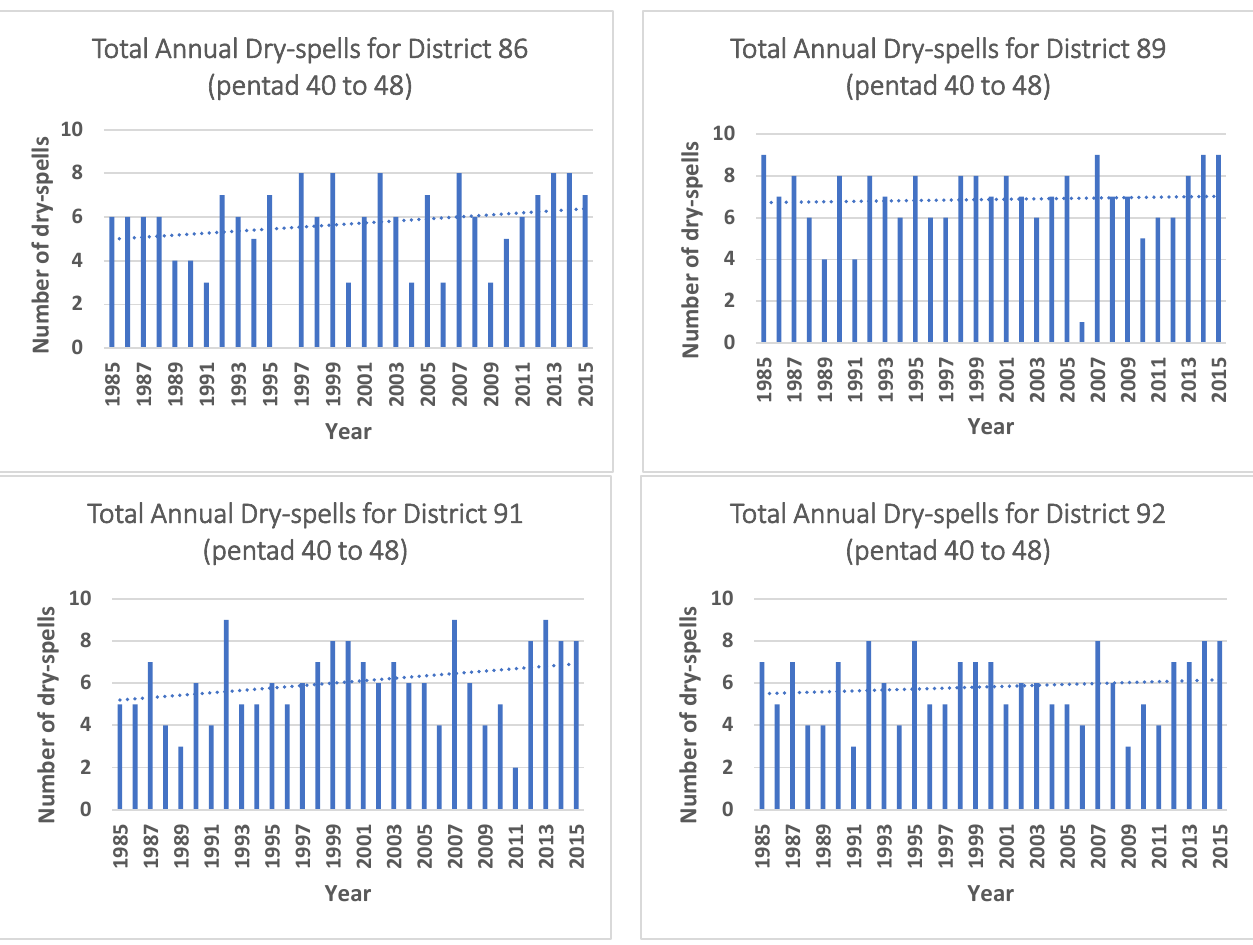
Figure 8. Trend analysis of the number of dry ‐ spells per year in SAWS rainfall district 83, 84, 86, 89, 91 and 92 during pentad 40 to 48.